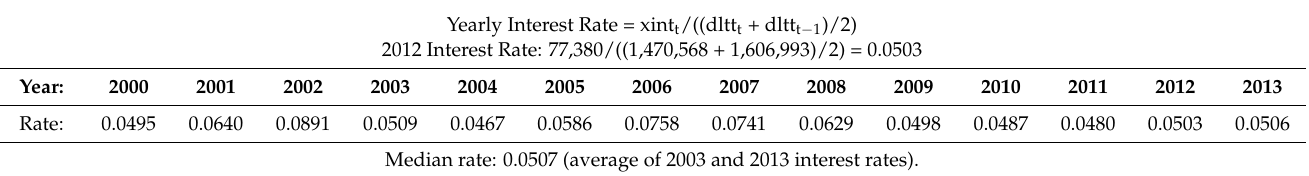
Firm-Specific Discount Rate